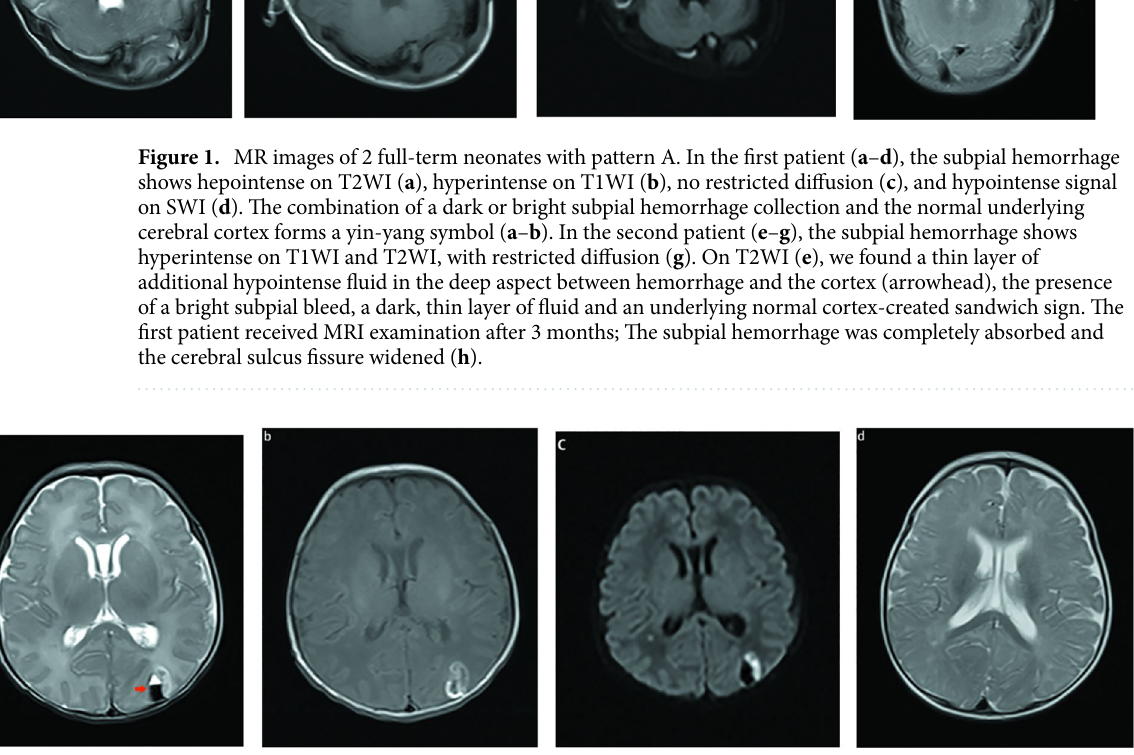
Figure 2. MR image of a full-term neonates with pattern B. The first MRI was performed at 5 days after birth ( a – c ). The subpial hemorrhage shows hypointense on T2WI and adjacent cortical infarction shows hyperintense ( a ), we found fluid–fluid level on subpial hemorrhage(arrow). Mixed signal on T1WI ( b ). There was no restricted diffusion in subpial bleed and hyperintense on cortical infarction ( c ). This combination of a dark subpial hemorrhage collection and the bright underlying cerebral cortex forms yin yang sign ( a and c ). Reexamination after 8 months showed that the subpleural hemorrhage had been basically absorbed, and there was no cortical infarction signal ( d